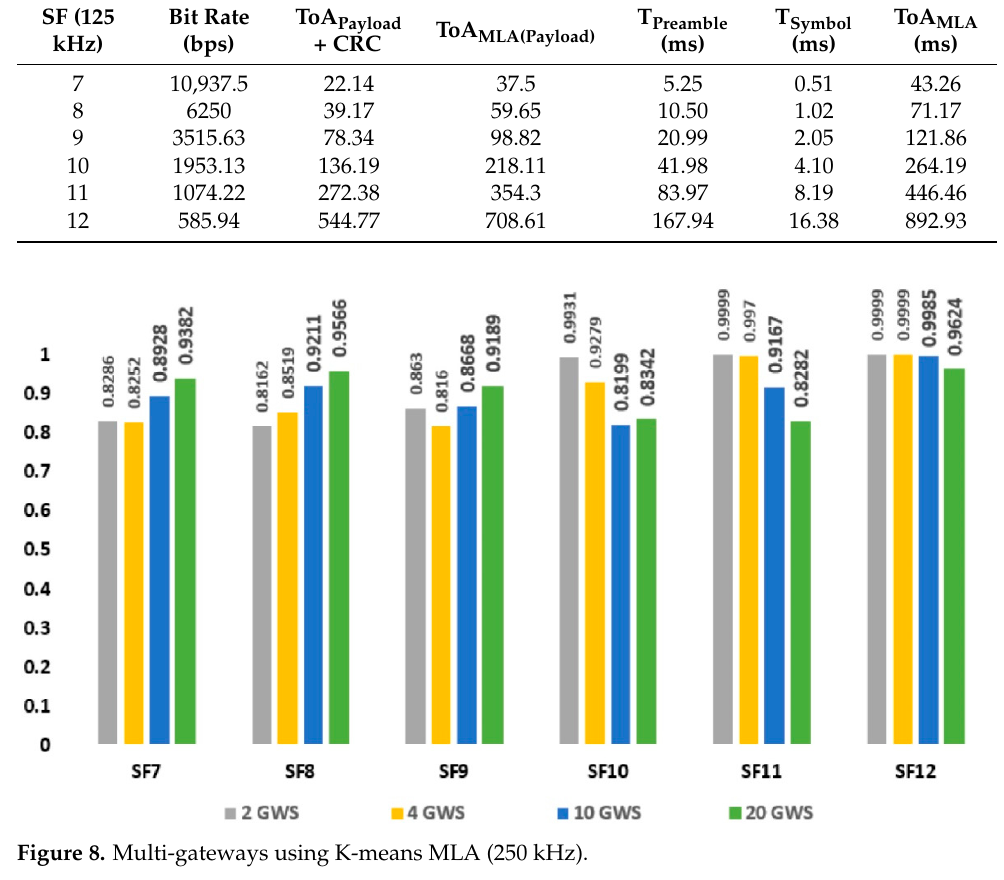
Table 8. Saturation comparison.